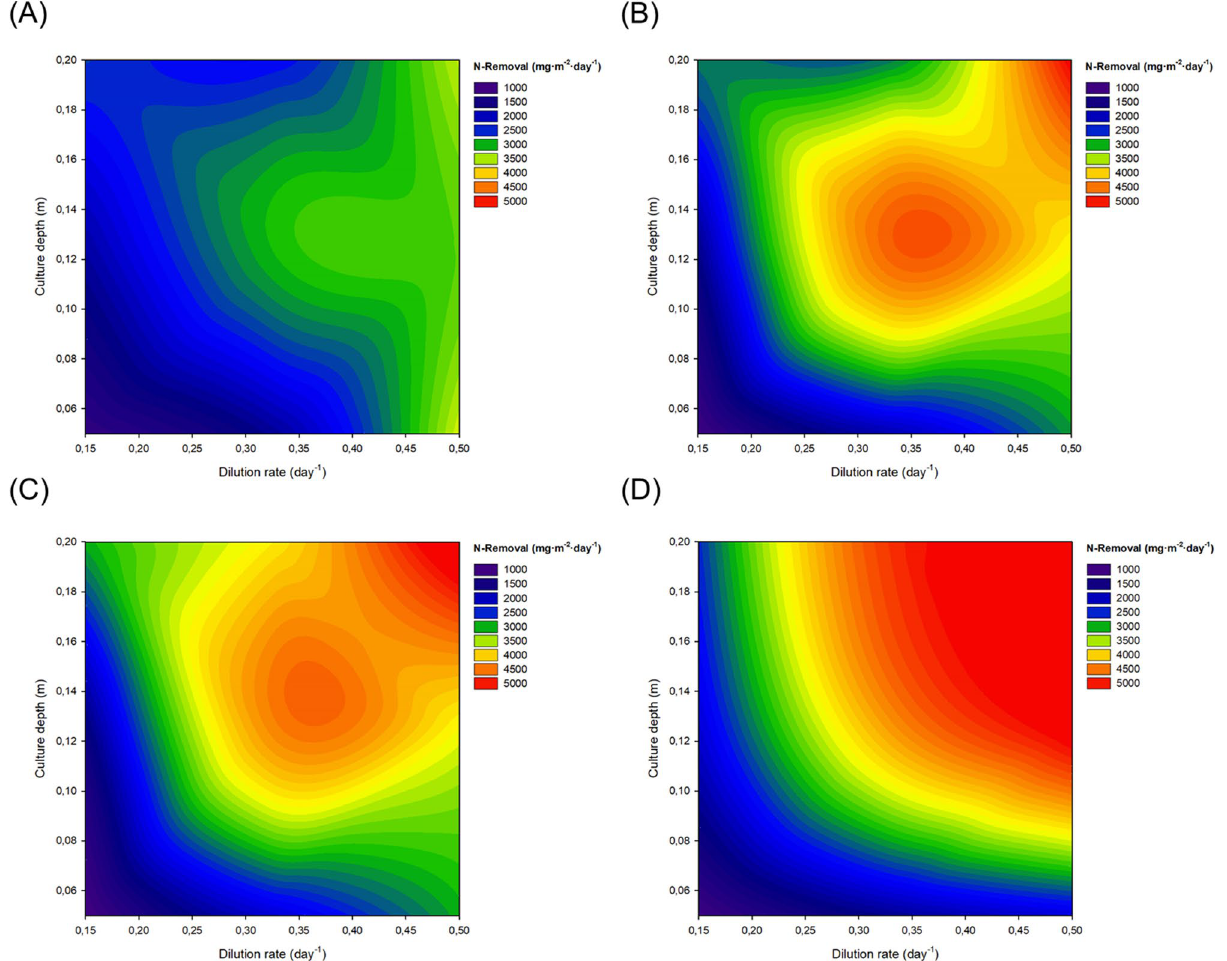
Figure 4. 2D contour plot of total nitrogen (N-NH 4 + and N-NO 3 − ) removal capacity of the reactors in (A) winter, (B) spring, (C) summer, and (D) autumn. Figure made using SigmaPlot v11.0 (Systat Software Inc., CA,